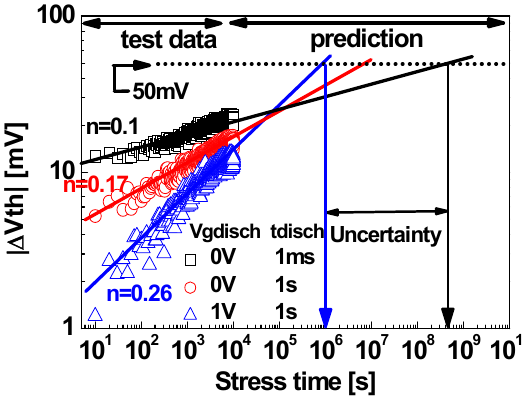
Figure 21. The power exponents extracted from test data depend on the delay between stress and measurement. The longer the delay, the larger the power exponent [38].